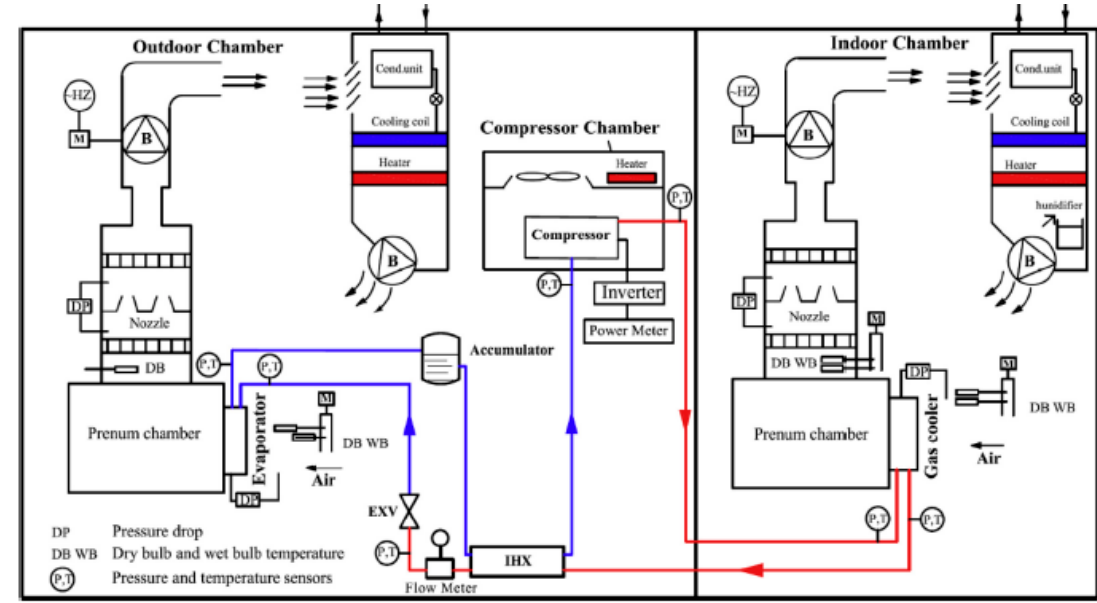
Figure 1. Calorimeter to measure heating performance characteristics of a heat pump system [19].